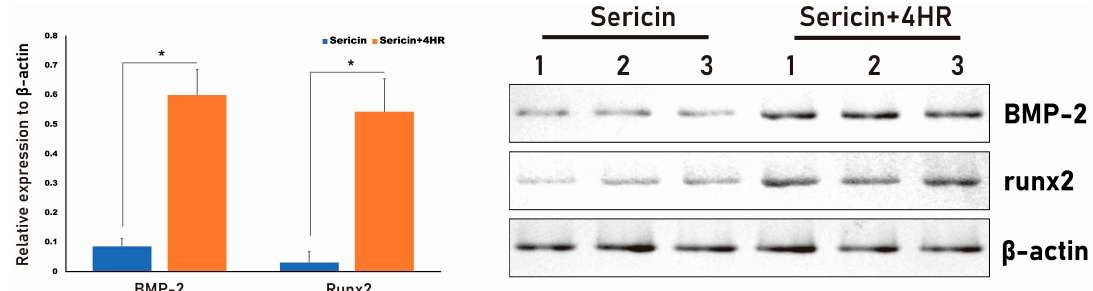
Figure 5. Western blot analysis of BMP-2 and runx2 proteins in tissue samples from the S and S+4 HR groups. Expression of BMP-2 and runx2 was significantly higher in the S+4HR group than in the S group. * p < 0.05.